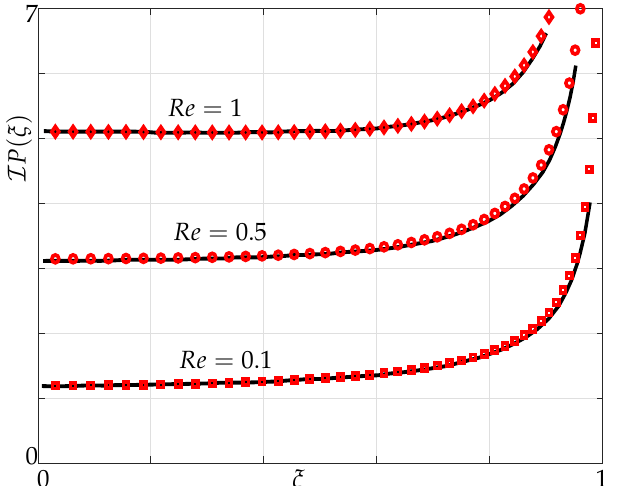
Figure 3. Variation of the imaginary part of pressure difference across the beam for Re = [ 0.1,0.5,1 ] ; our simulations Equation (5) (markers) and Tuck’s results (solid